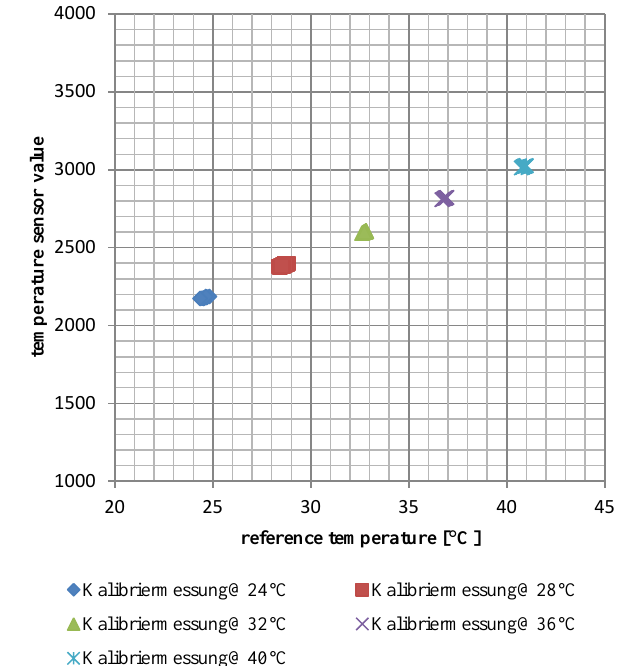
Figure 21. Temperature–calibration error (including 1-sigma noise) at different temperatures.